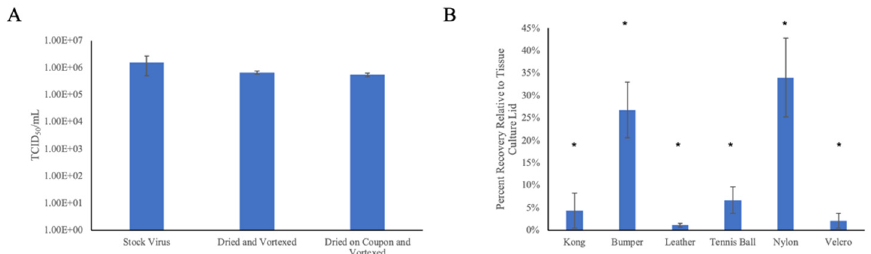
Figure 4. The effect of drying and surface characteristics on recovery of viable virus. ( A ) Recovery